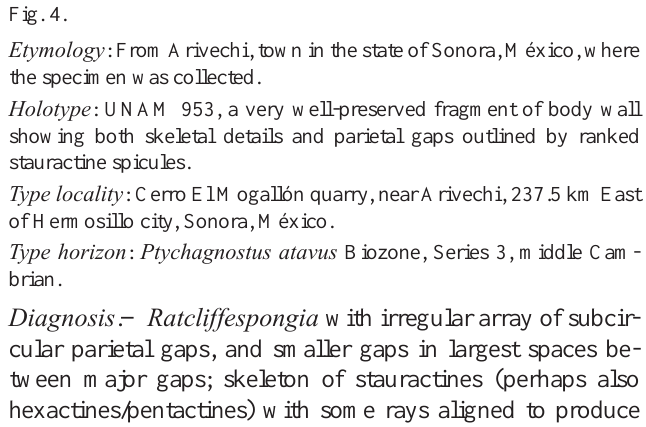
Etymology : From Arivechi, town in the state of Sonora, México, where the specimen was collected. Holotype : UNAM 953, a very well-preserved fragment of body wall showing both skeletal details and parietal gaps outlined by ranked stauractine spicules.